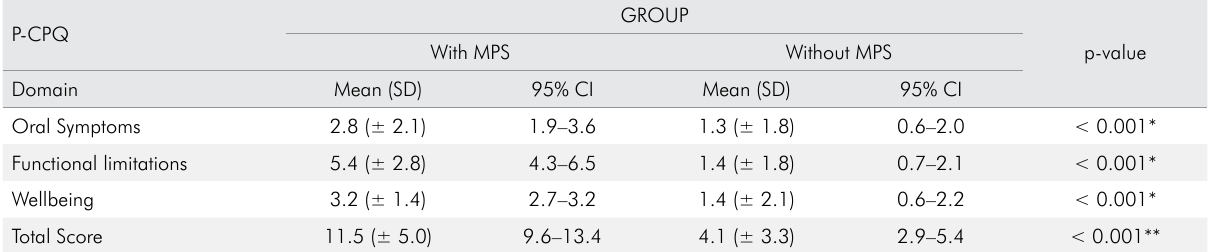
Table 2. Mean total P-CPQ score and domain scores (n = 58).